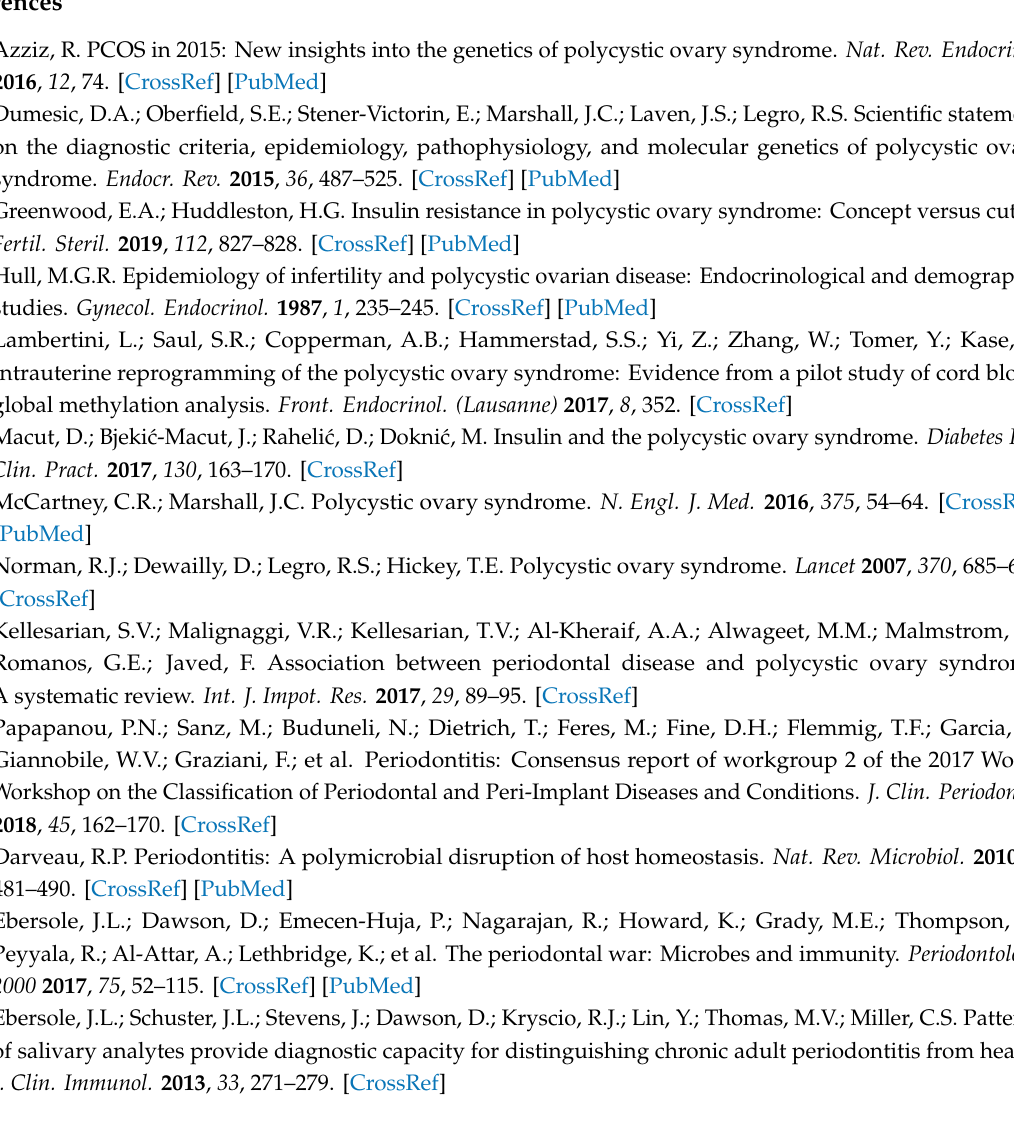
Table S1: List of excluded articles, Table S2: Case-control studies bias assessment using the Newcastle-Ottawa Scale